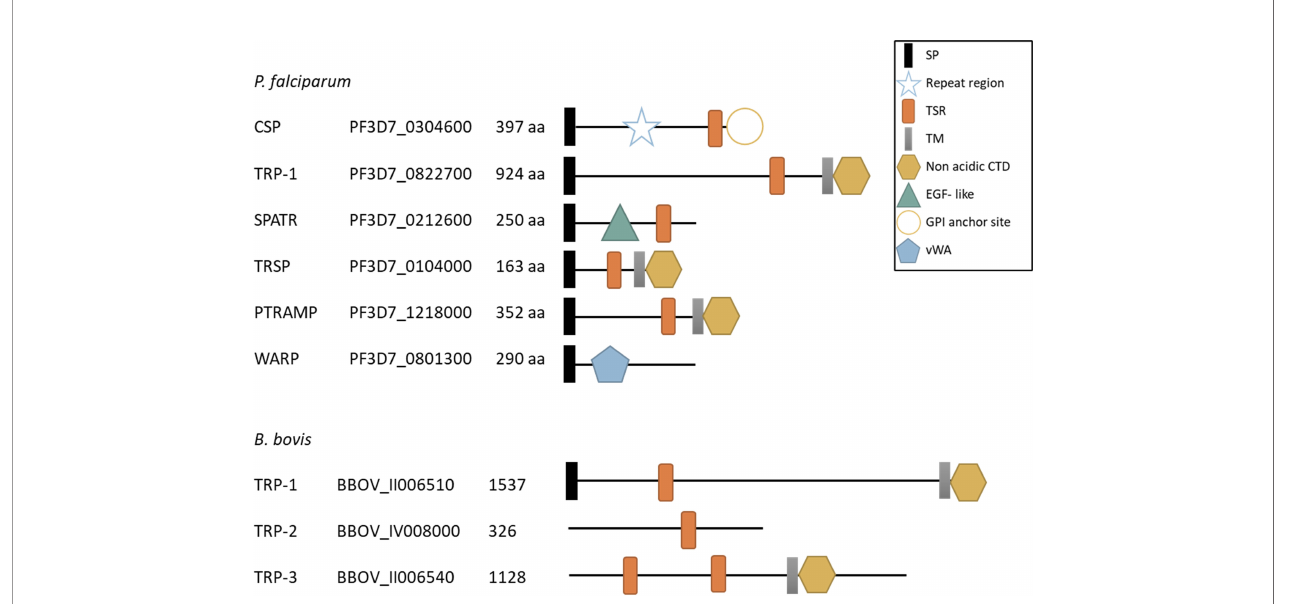
FIGURE 3 | Schematic representation of TRP- family proteins in P. falciparum and B. bovis . SP, signal peptide; Repeat region, CSP central region with a variable number of repeats; TSR, thrombospondin type 1 repeat domain; TM, transmembrane domain, non acidic CTD, non acidic cytoplasmatic tail domain; EGF- like, type II EGF- like domain; GPI anchor site, glycosylphosphatidylinositol (GPI) anchor site; vWA, von Willebrand factor type A domain; aa, number of amino acids in the protein. The accession number provided corresponds to the VEupathDB database